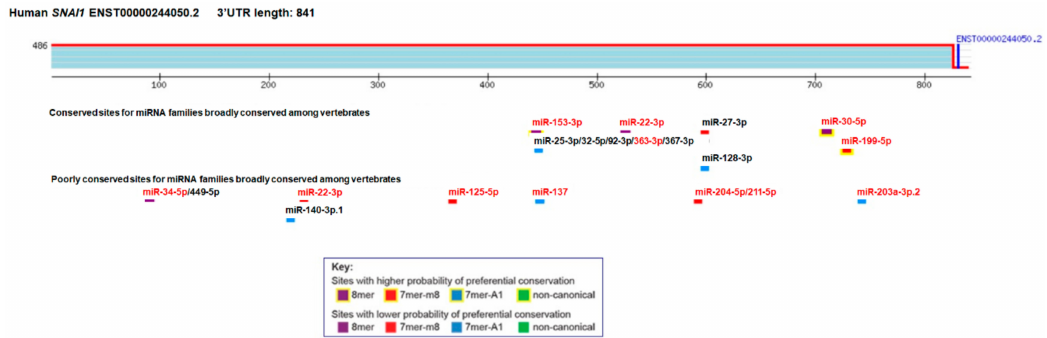
Figure 2. MicroRNAs targeting the 3 (cid:48) untranslated (3 (cid:48) UTR) region of SNAIL from bioinformatical analysis using TargetScanHuman 7.1 (access: 22 October 2019). Experimental evidence for direct binding to SNAIL 3 (cid:48) UTR was shown in the literature for miR-153, miR-22, miR-30, miR-363, miR-199, miR-34, miR-22, miR-137, miR-203, miR-125, miR-211, and miR-203 (marked in red), which is described in the text